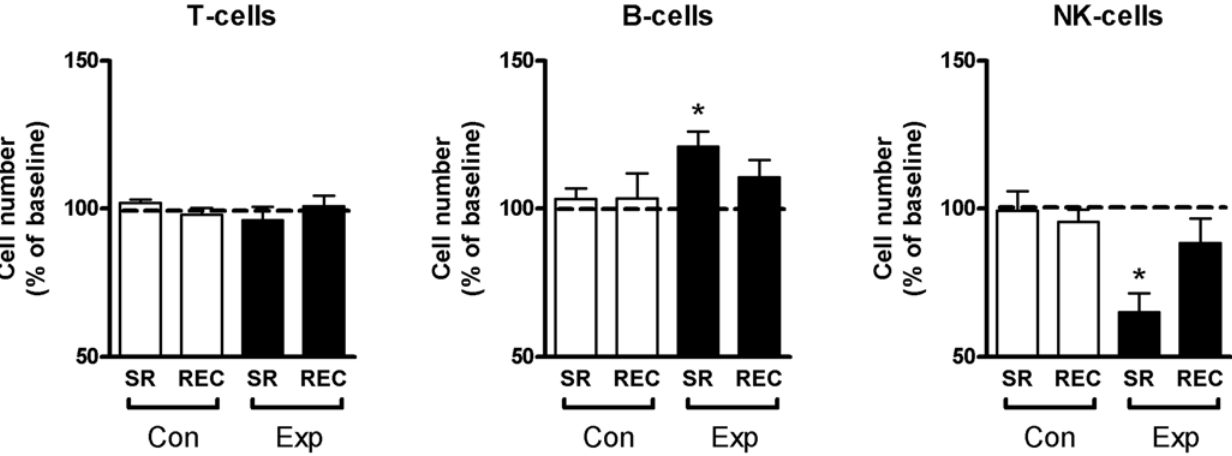
Figure 1. Cell distribution of PBMC. Number of T cells, B cells, and natural killer (NK) cells in PBMC, expressed as percentage of participant’s individual baseline values. SR=sleep restriction, REC=recovery, Con=control group, Exp=sleep restriction group. Data are presented as mean